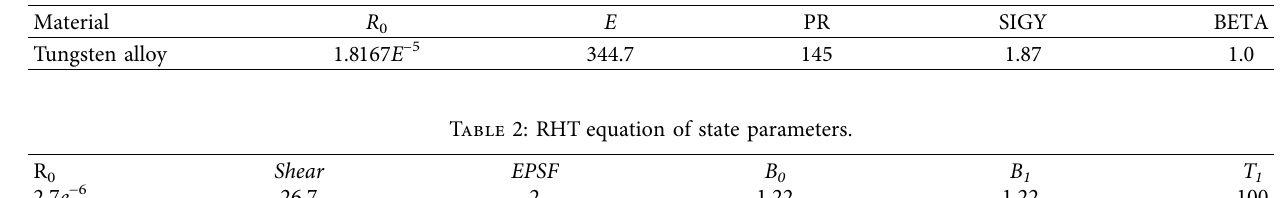
Table 1: Tungsten alloy material parameters.